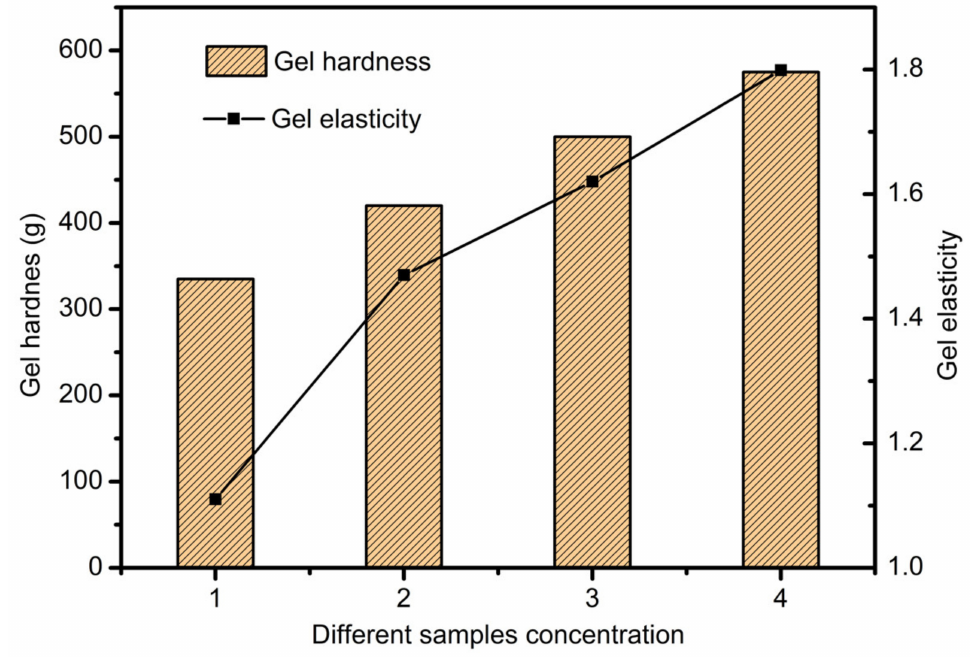
Figure 1. The e ff ects of di ff erent concentrations on the hardness and elasticity of the